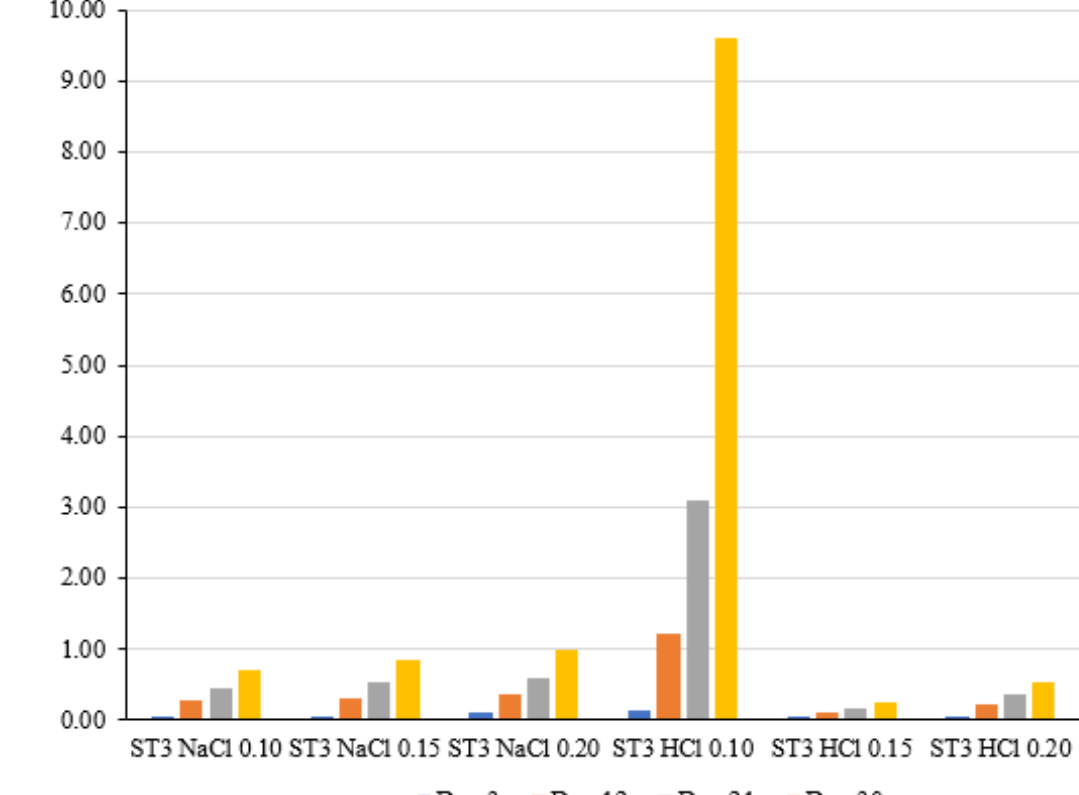
Figure 9. Effect of heat treatment on corrosion behaviour of S T3 (6%).